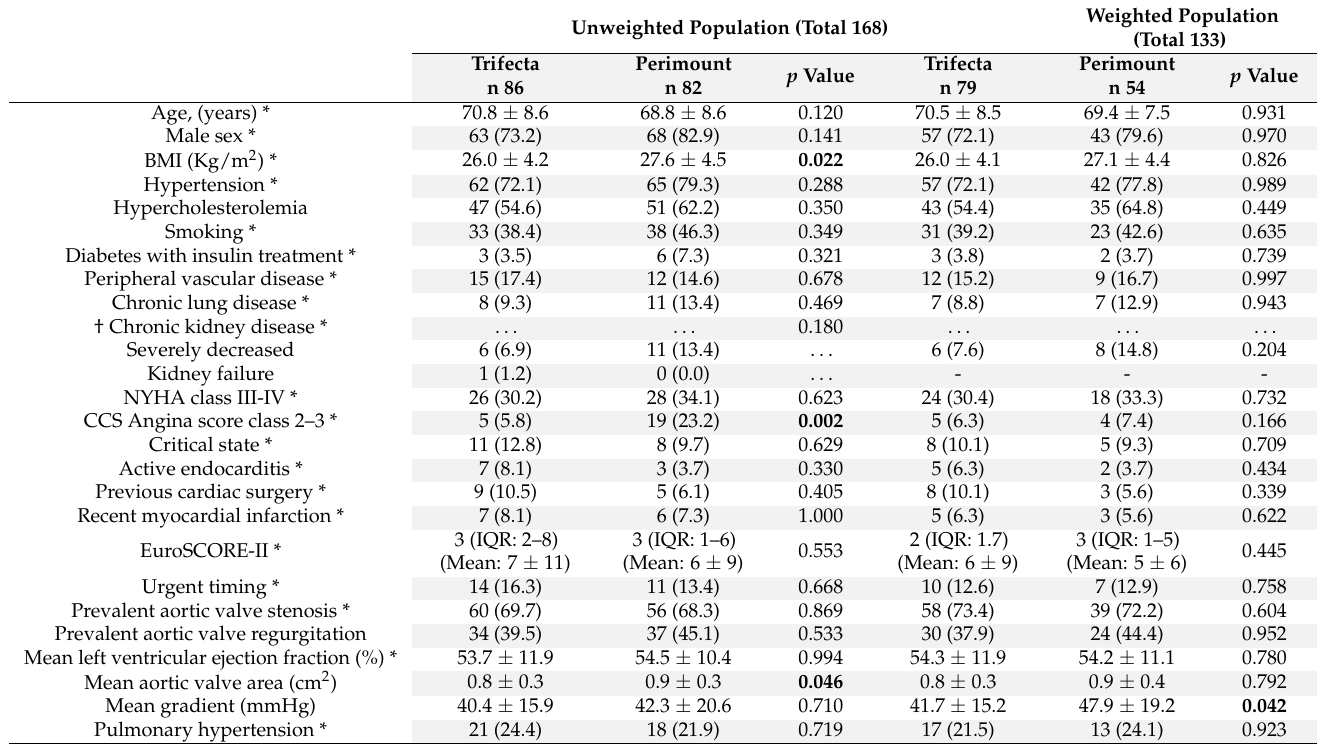
Table 1. Baseline and preoperative echocardiographic